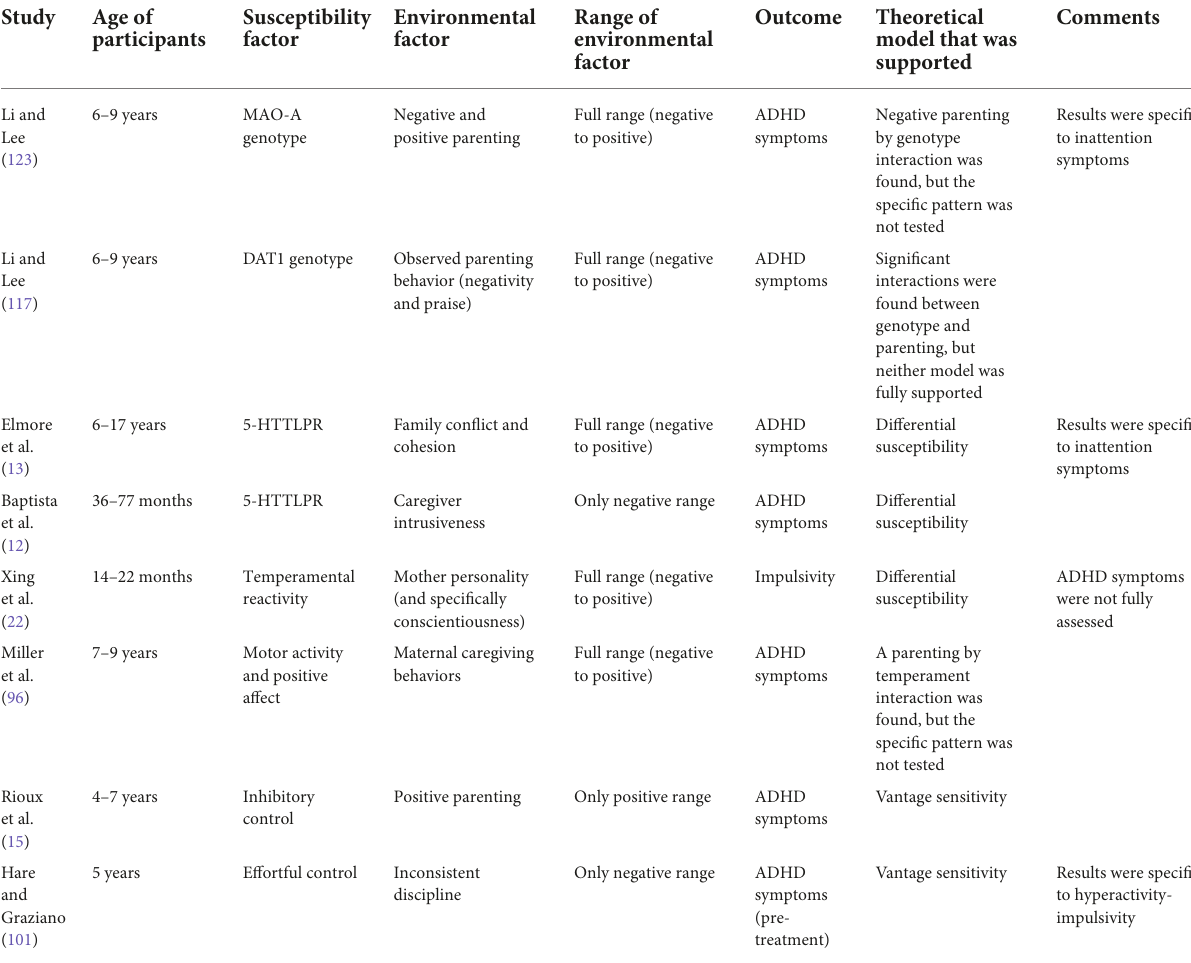
TABLE 1 An overview of studies that tested sensitivity to positive aspects of the environment in ADHD.